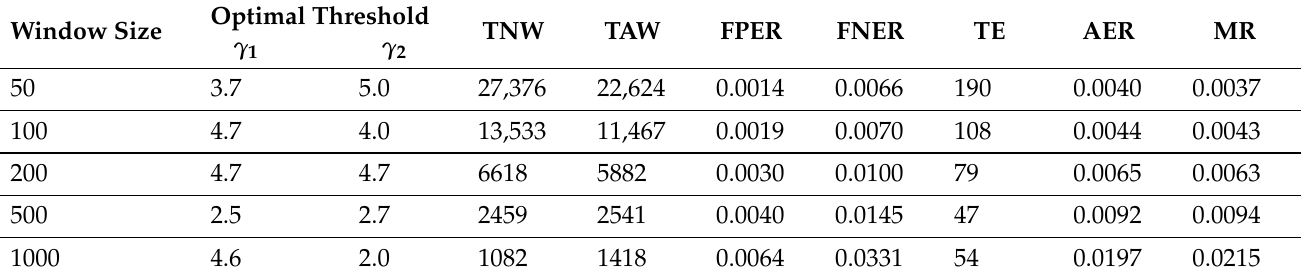
Table 11. Performance evaluation using optimum threshold value (merged attack).